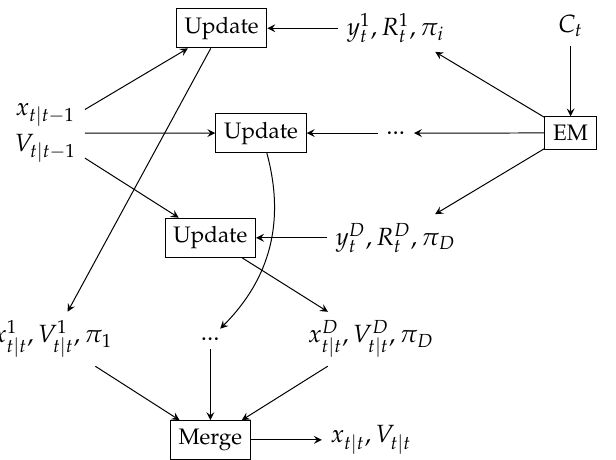
Figure 4. Update the state estimate by applying evidence modeled by Gaussian Mixture; EM estimating RF signal distribution from cell C t visited at time t ; updating the state estimation x t | t − 1 using Gaussians from the mixture; merging resulting Gaussian